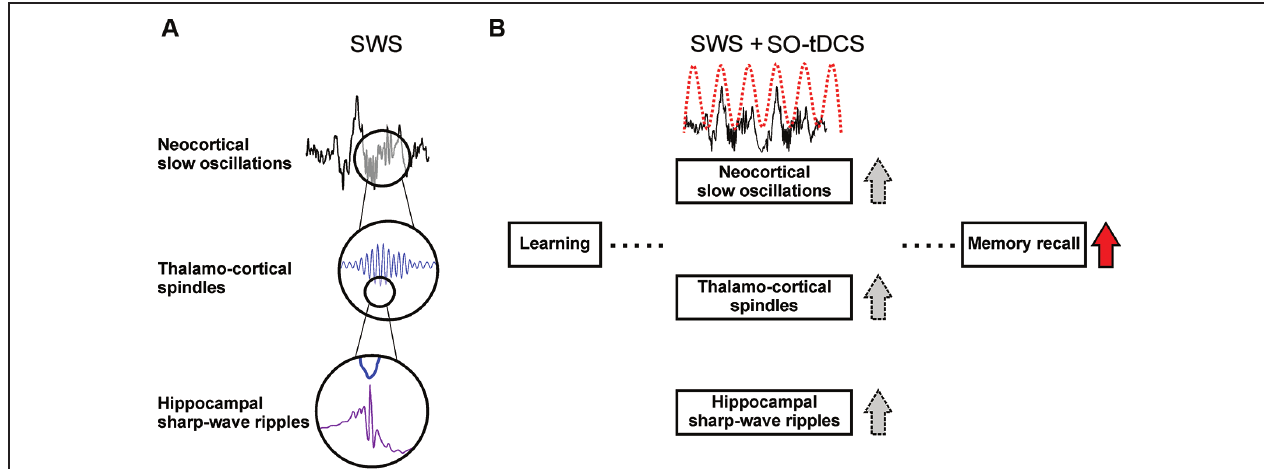
subserve the communication between hippocampus and neocortex (Sirota et al., 2003) and therefore the transfer of hippocampus-dependent memory traces from the hippocampal short-term-store to the neocortical long-term store (for review see Marshall and Born, 2007). (B) SO-tDCS is assumed to enhance endogenous SO activity, and thus improve the consolidation of memory. It was shown that SO-tDCS enhances post-stimulation power of EEG SO and spindle activity as well as memory consolidation in a hippocampus-dependent task (Marshall et al., 2006). A simultaneous enhancement of these rhythms and SWRs during SO-tDCS yet needs to be